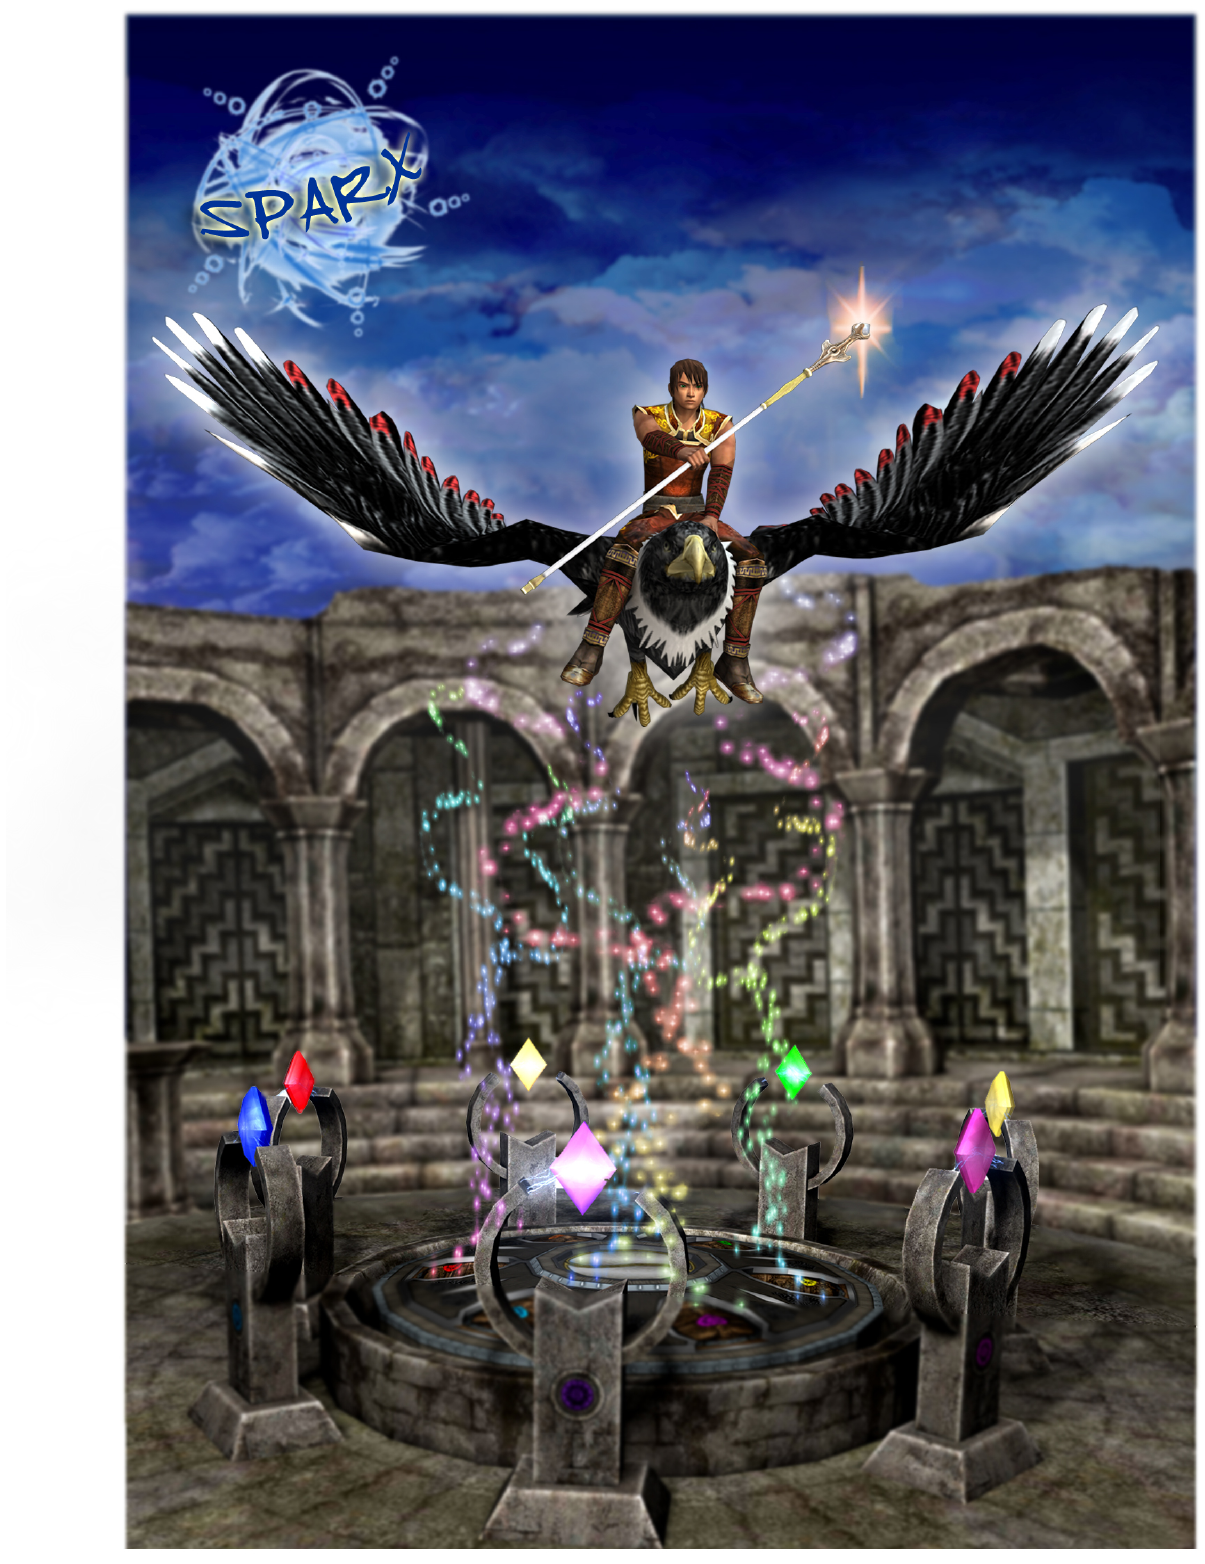
Figure 1. Picture of the poutama (staircase)